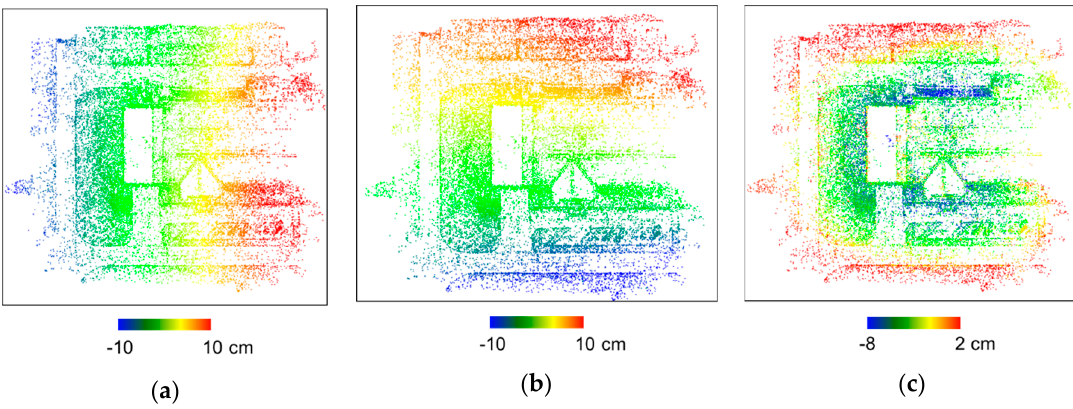
Figure 8. Top view of the sparse point cloud colored by ( a ) X discrepancy, ( b ) Y discrepancy, and ( c ) Z discrepancy caused by a bias in the radial distortion coefficient, 𝐾1 , for the A-1 dataset.